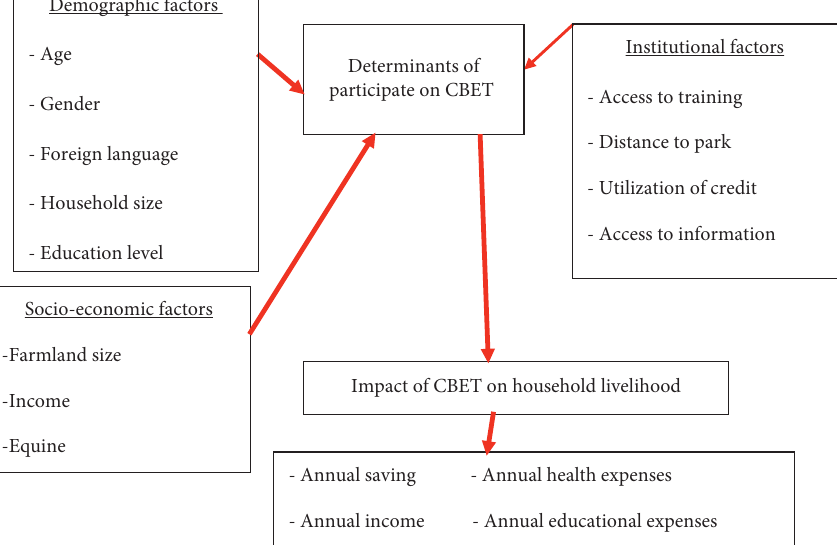
Figure 1: Impacts of ecotourism on household financial assets and its determinants